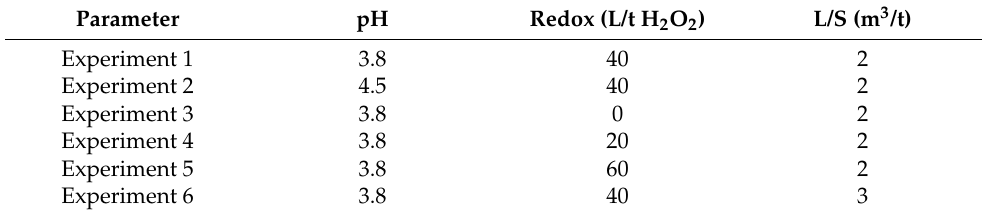
Table 2. Experimental setups for laboratory-scale experiments.